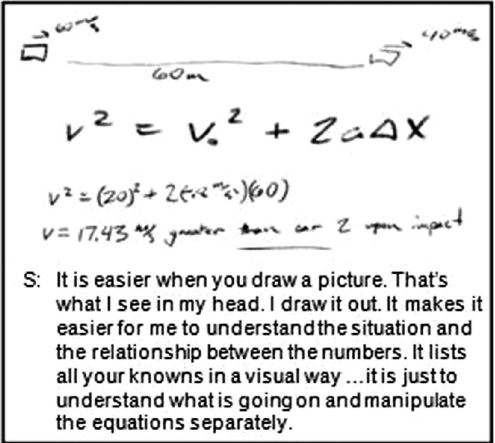
FIG. 10. Solvevalue from symbolic representation (question 3).